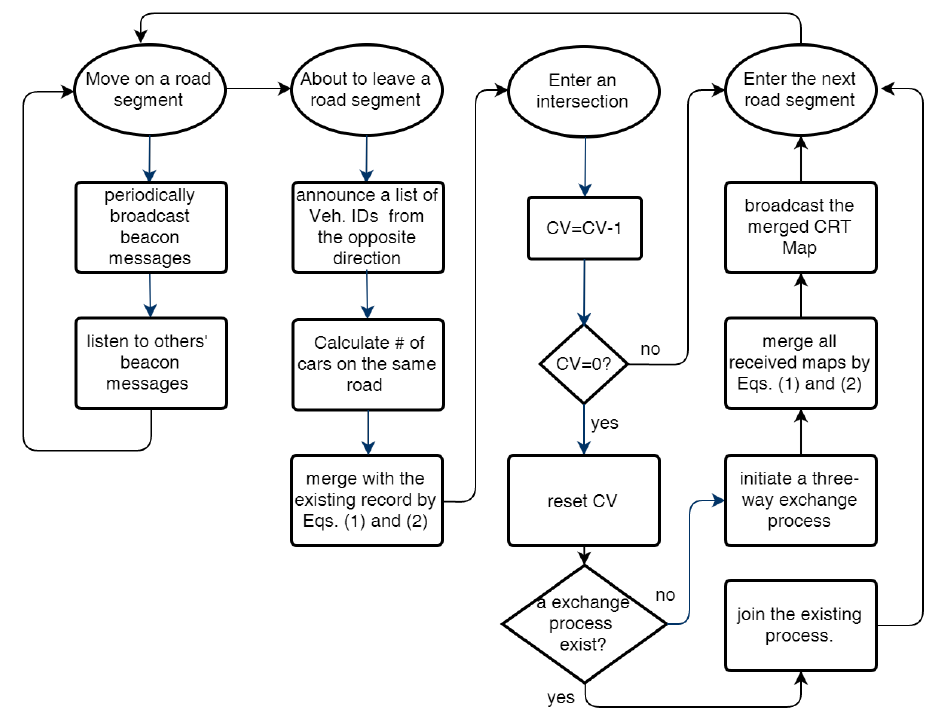
Figure 4. A flowchart of Comprehensive Real-Time Traffic Map (CRT Map) construction and message exchanges for each vehicle.